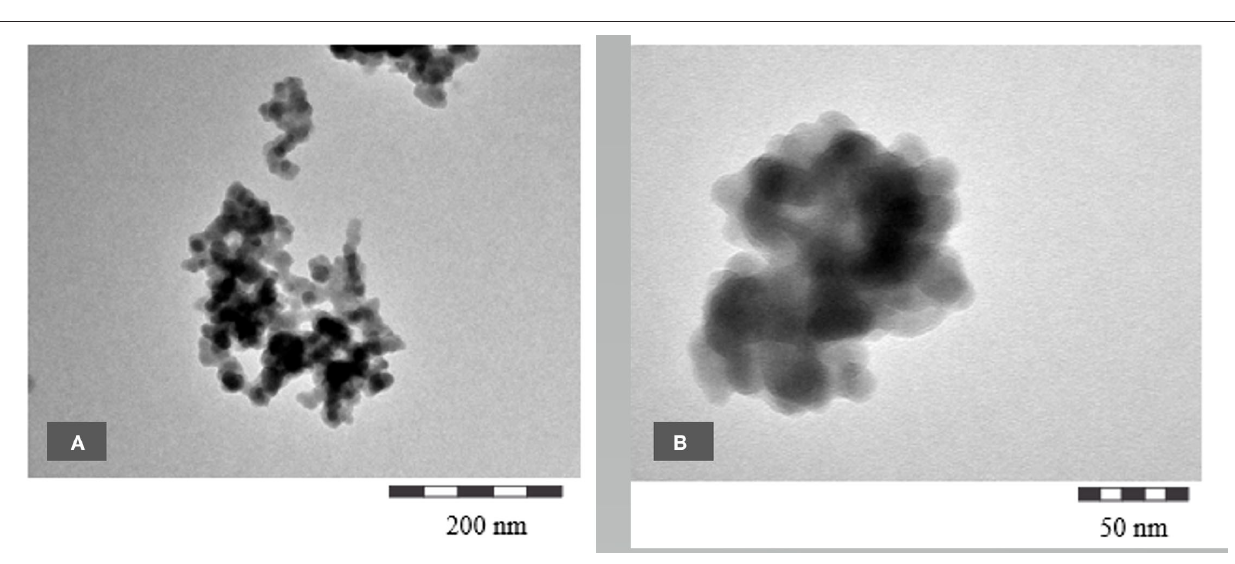
FIGURE 15 | (A,B) TEM micrographs of SIPERNAT ® 22 at different